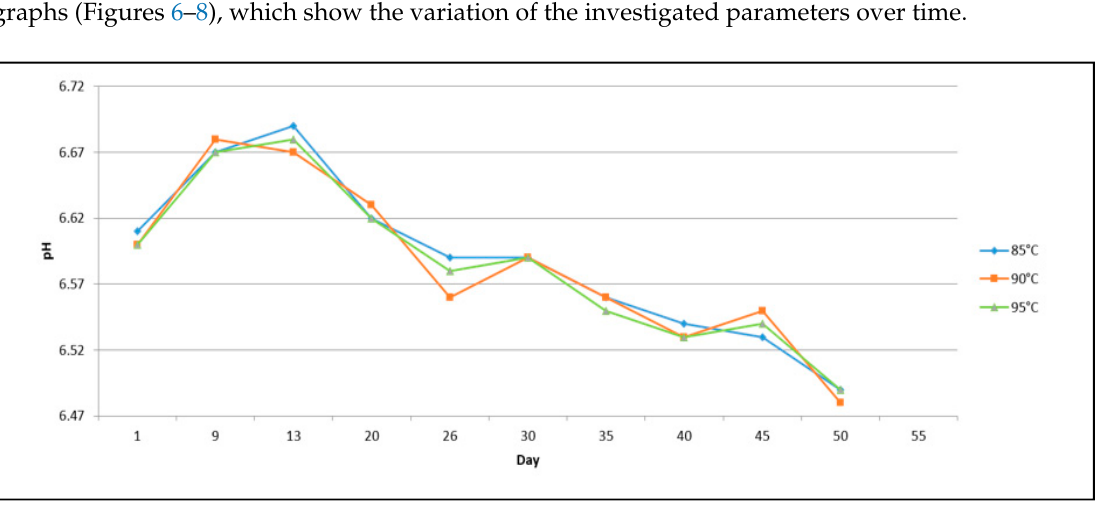
Figure 7. Measurements of acidity during a storage period of 55 days at 4 °C. Figure 8. Measurements of TMC during a storage period of 55 days at 4°C. Milk undergoes natural degradation; however, normal values for pH, acidity, and TMC have been observed until day 45. In general, commercial ESL milk on the market, which is subjected to heat treatments with temperatures higher than 120 °C, has a shorter shelf life, i.e., approximately 20– 25 days. In order to explain the persistent microbial activity that emerged from the trends for pH and